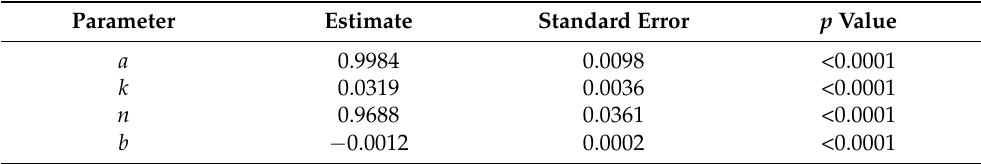
Figure 5. Drying data of peach slices at 60 °C (gray circles). Solid blue line indicates the fit of modified Henderson–Pabis model [Equation (6)] (R 2 = 0.9931 and RMSE = 0.0285) and two-term model [Equation (7)] (R 2 = 0.9931 and RMSE = 0.0266). Dashed red line indicates the fit of Midilli model [Equation (8)] (R 2 = 0.9989 and RMSE = 0.0104). Original data are from Zhu and Shen [19]. Table 4. Parameter estimates, standard errors and p values of the Midilli–Küçük model [Equation (8)] to the data shown in Figure